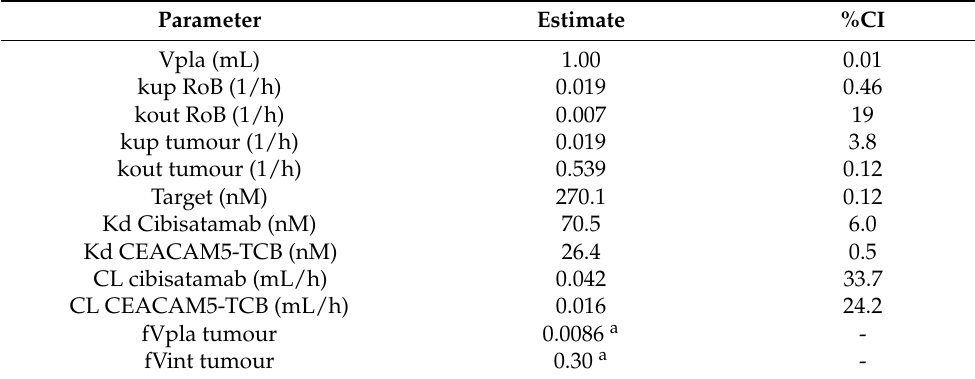
Table 1. Parameter estimates of the tumour uptake